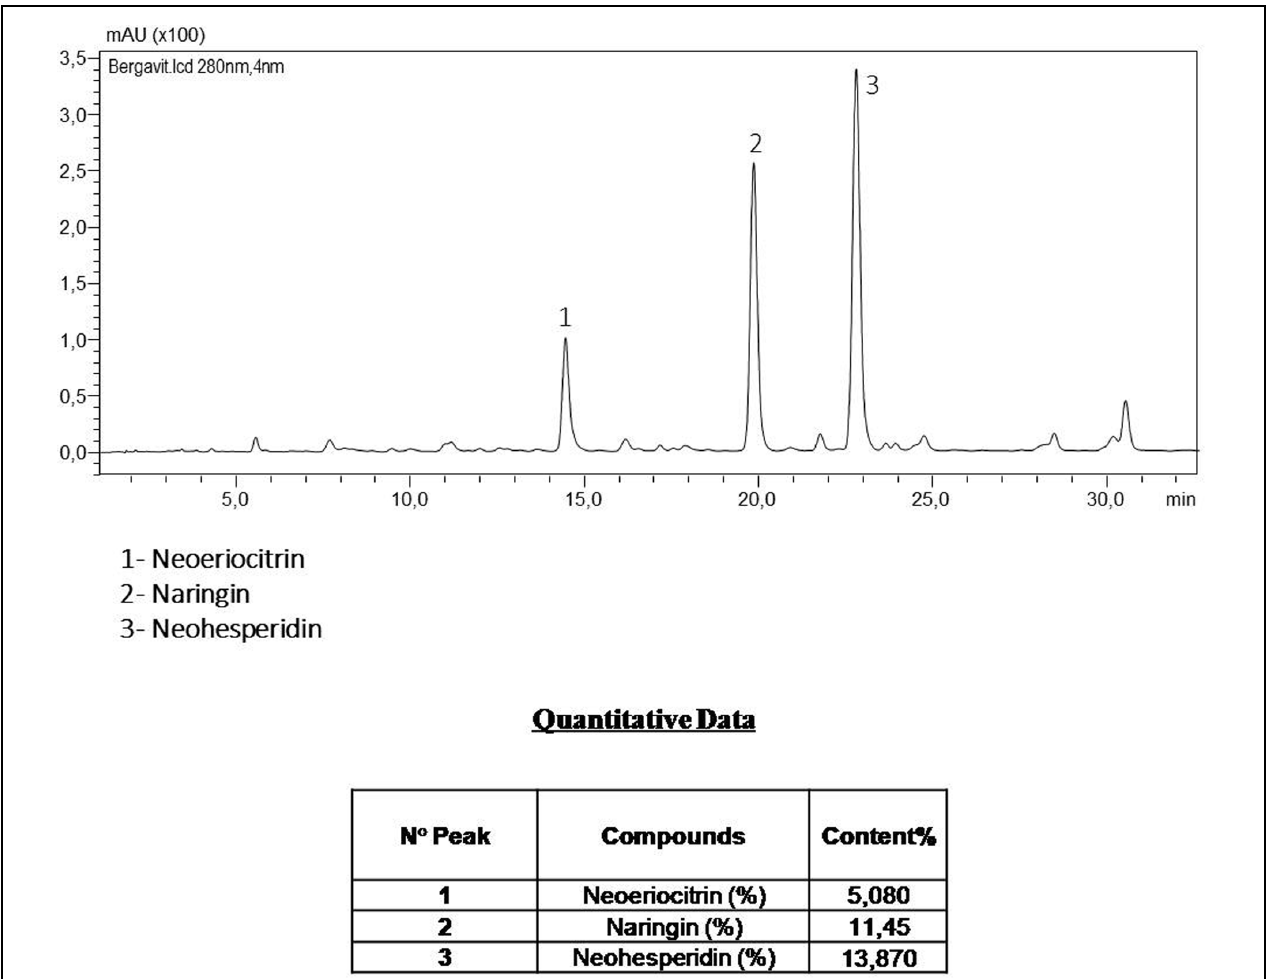
FIGURE 1 | The components of Bergavit R (cid:2) separated by high-performance liquid chromatography (HPLC-DAD Analysis 280 nm), as determined by Bionap. The chromatographic analyses are determined on a Shimadzu LC system by